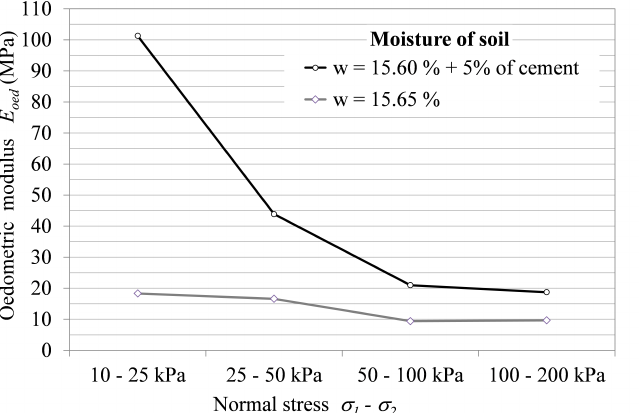
Figure 4. Influence of addition 5 % cement into the soil on E